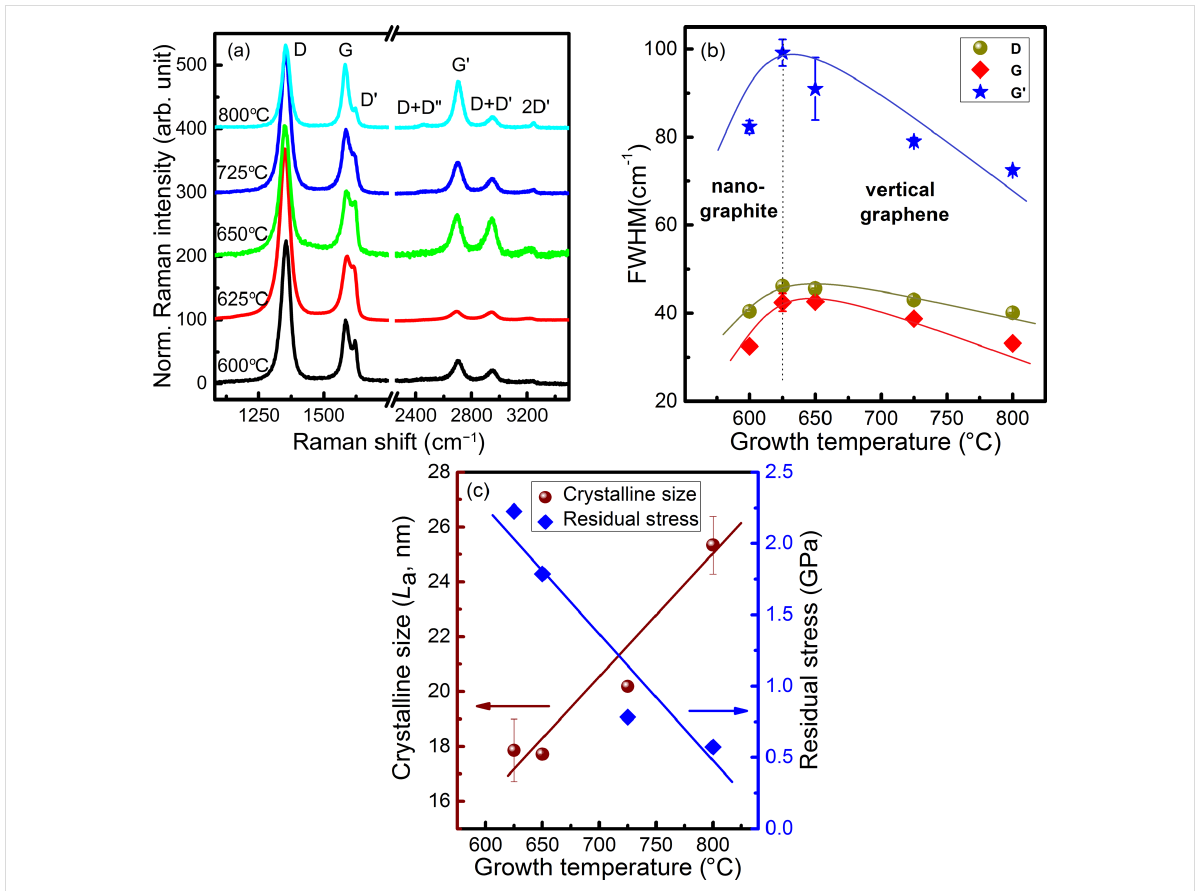
Figure 3: (a) Raman spectra of VGNs grown at different substrate temperatures. (b) Values of full widths at half maximum (FWHM) of D, G, and G ′ bands, and (c) residual stress and crystallite size as a function of the growth temperature. Solid lines are to guide the eye.